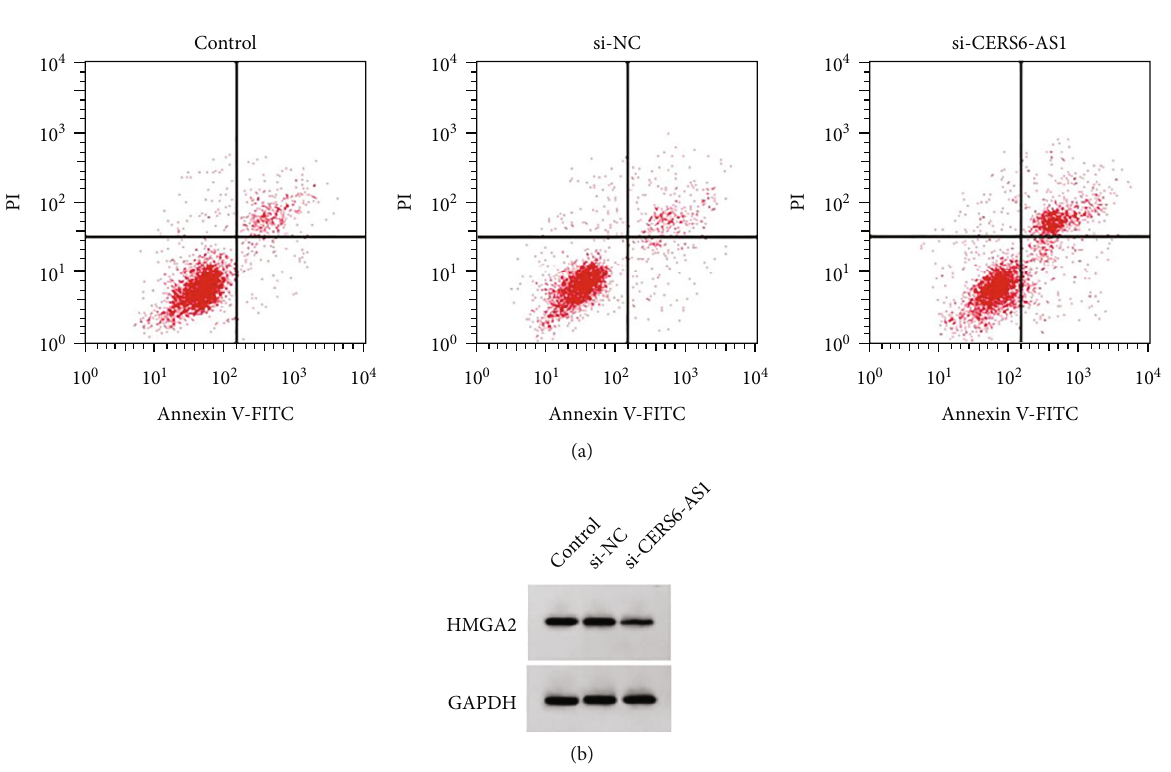
Figure 3: E ff ect of silencing CERS6-AS1 on DU145 apoptosis and HMGA2 protein